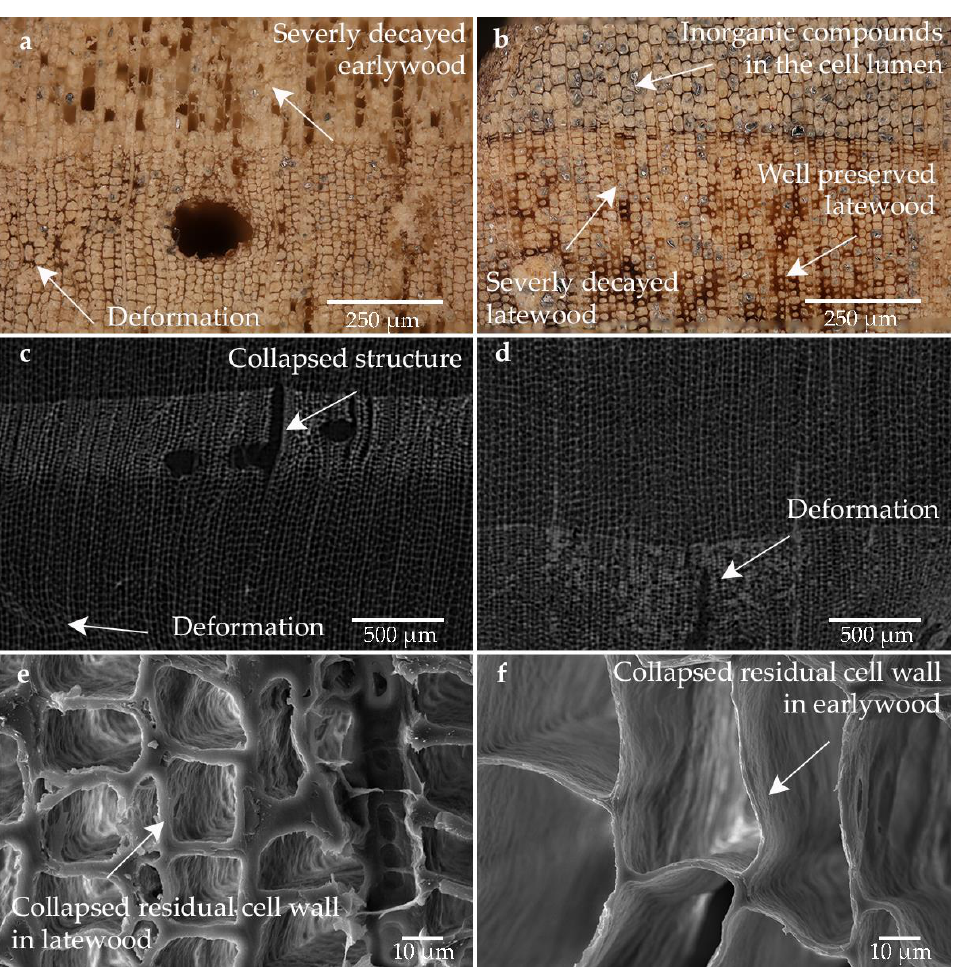
Figure 2. Microscopic wood structure of the untreated, air-dried sample (Pi1-Air) ( a ) RLM image from the high degraded area ( b ) RLM image from the low degraded area; where the inorganic inclusions are visible; ( c ) CT image of the cross section of the heavily degraded sample; ( d ) CT image of the cross section of the low degraded sample; ( e ) SEM image of the latewood tracheids; ( f ) SEM image of the earlywood tracheids in the heavily degraded area. Table 1. Physical and chemical properties of the